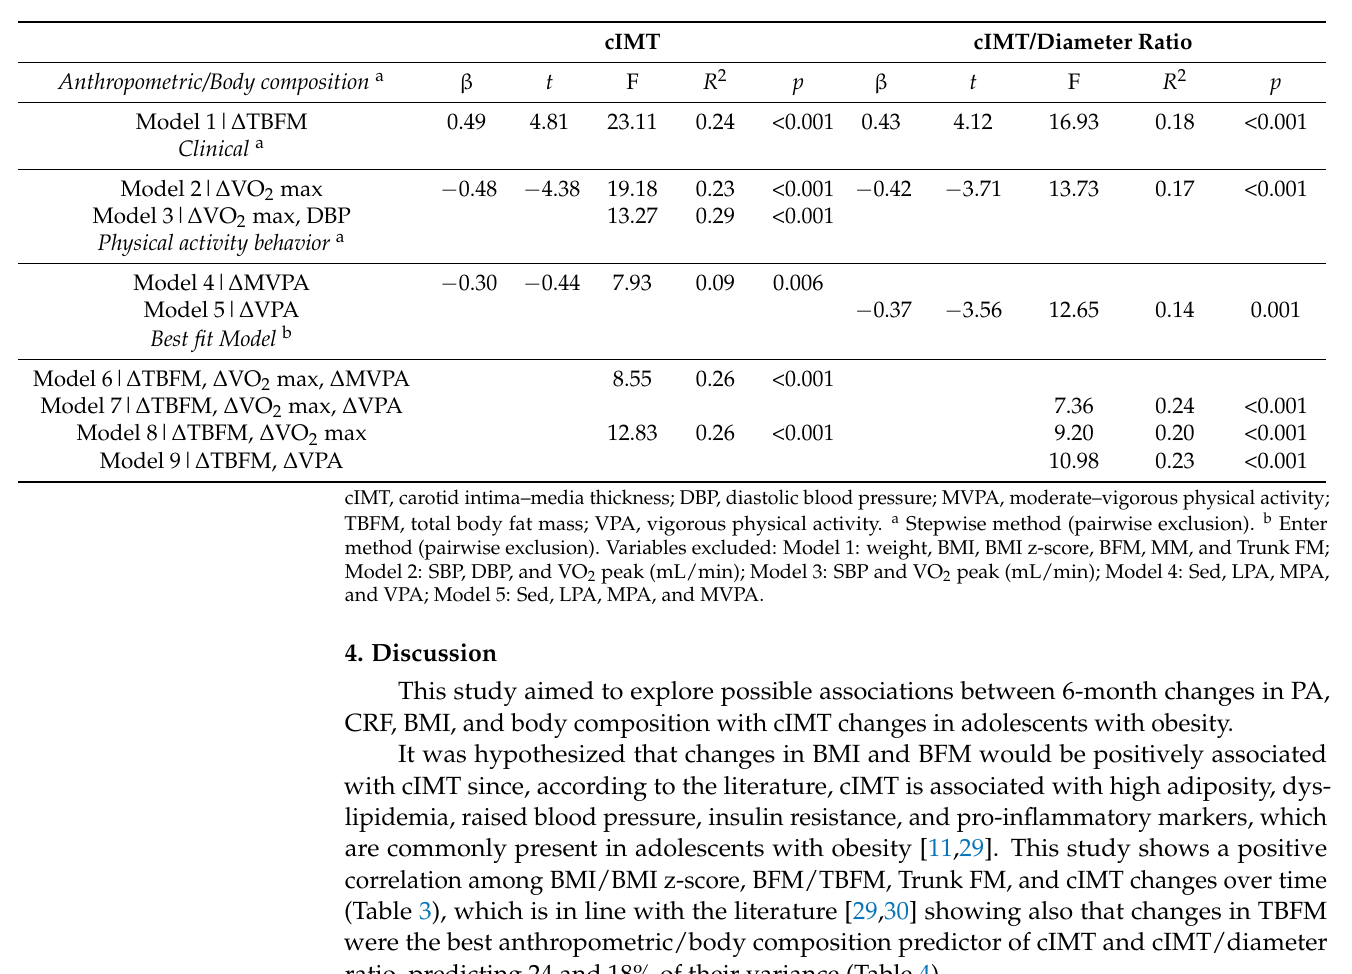
Table 4. Multiple regression models with carotid intima–media thickness (cIMT) and cITM/diameter ratio as dependent